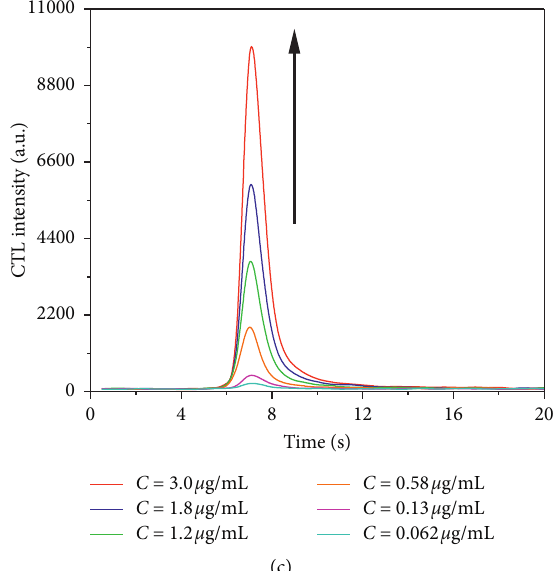
Figure 4: (a) CTL response to IBD by different materials; (b) CTL response to different VOCs by nano-Sm versus time for different concentrations of IBD on nano-Sm 2 O 3